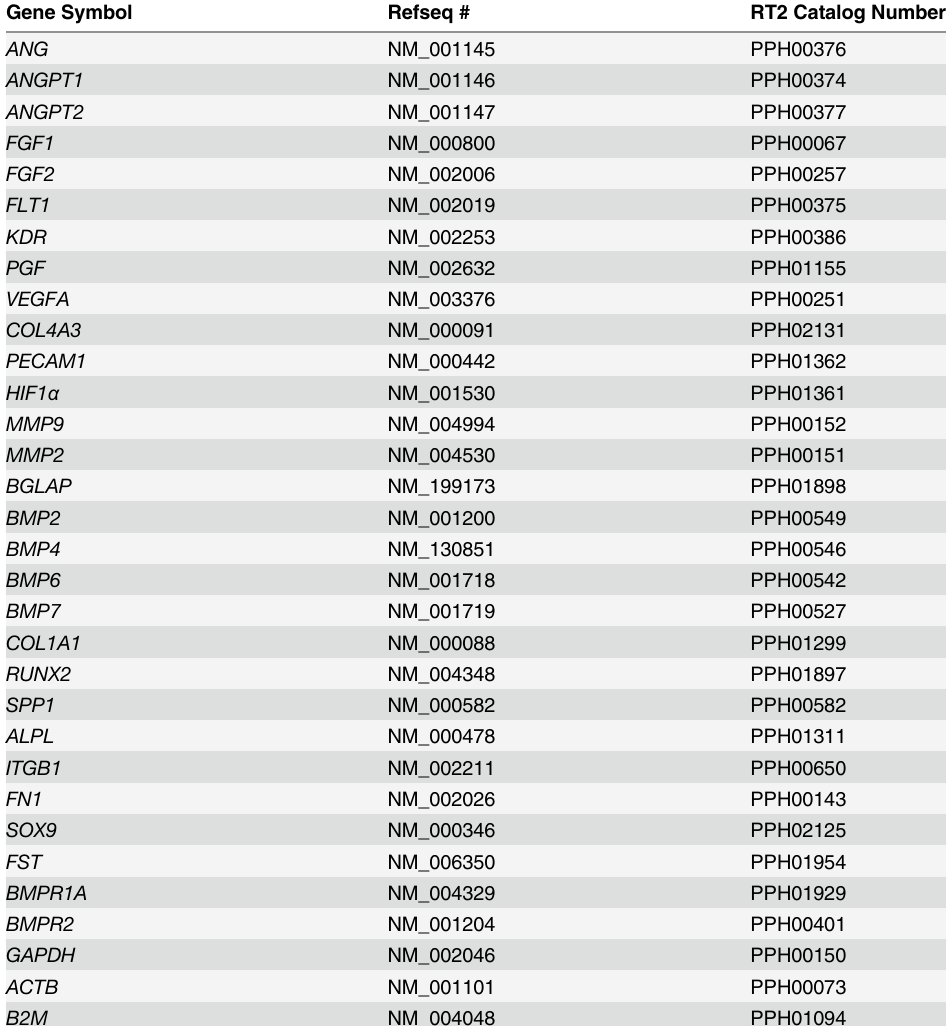
Table 1. Genes used in the custom qRT-PCR